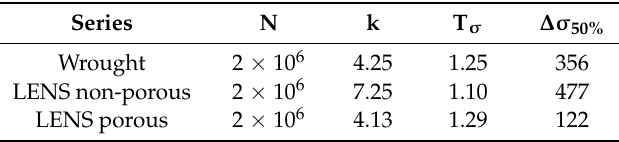
Figure 5. S-N fatigue data from wrought specimens. Table 3. Results from fatigue tests at 1 × 10 6 cycles.